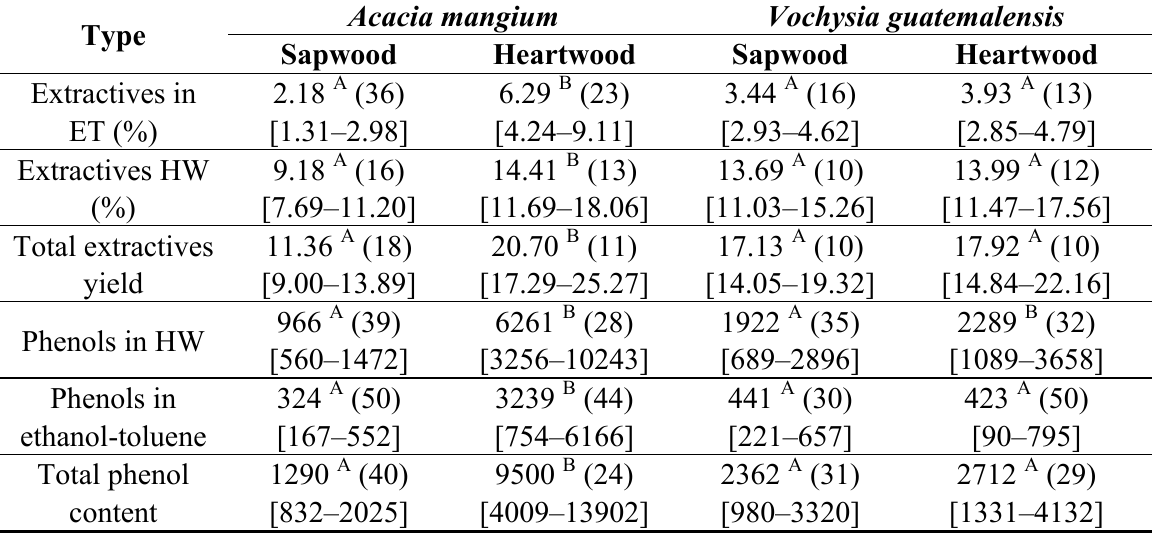
Table 2. Extractives in ET and HW and phenol content in ET and HW extracts for Acacia mangium and Vochysia guatemalensis